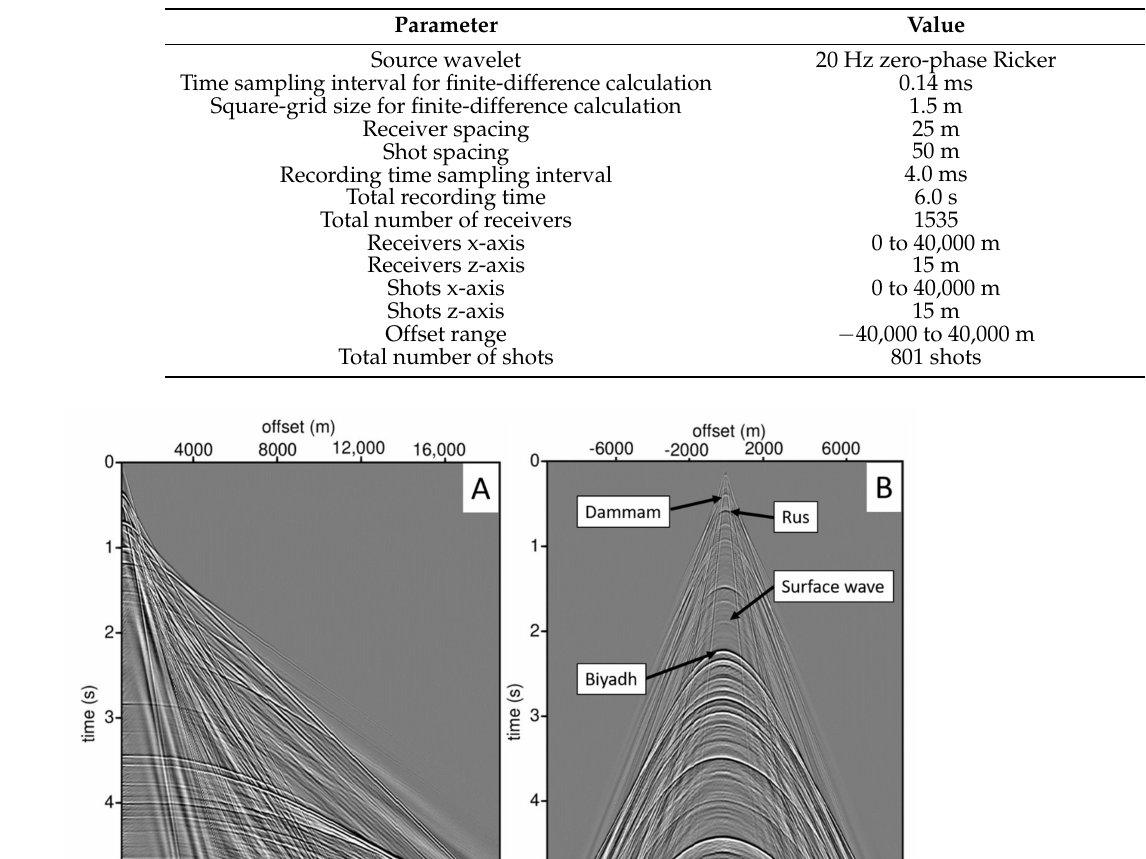
Table 2. List of parameters used to construct synthetic seismic data.